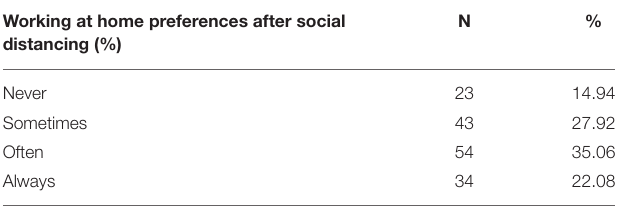
TABLE 3 | E-working productivity.